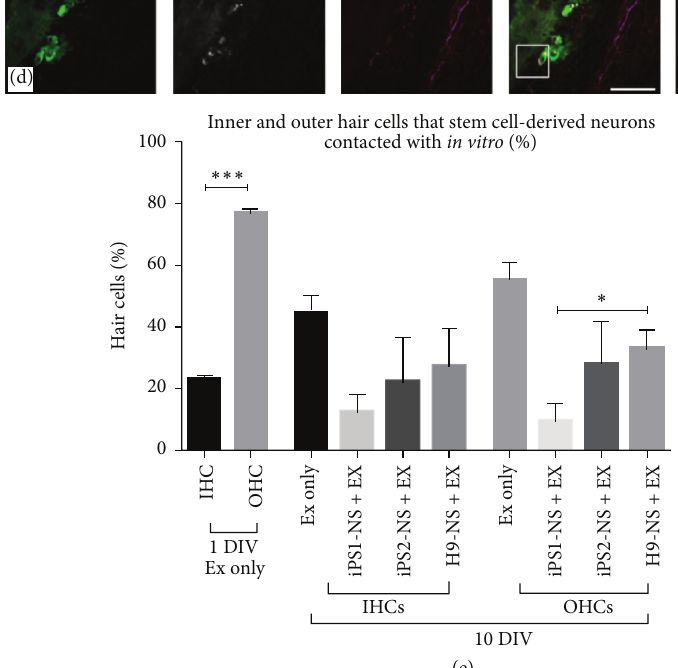
Figure 3: Innervation of inner hair cells versus outer hair cells by stem cell-derived neurons. (a) The specific labeling of Prestin (grey) to the OHCs is depicted in the explant only control. (b–d) The hiPSC- and hESC-derived neural processes made contact with both the IHCs and the OHCs. The merged 1 images represent higher magnification images of the boxed inserts and depict the contacts made between the stem cell-derived neural processes and hair cells. Scale bar = 50 𝜇 m, relevant for all the images. (e) Total numbers of hair cells (inner and outer) were quantified in each group using antibodies against MyoVIIa (all hair cells) and Prestin (outer hair cells only). Data was compared to controls grown for one day in vitro . There was a significantly higher number of OHCs compared to IHCs in the explant only controls after 1 DIV ( 𝑝 < 0.001 ). At 10 DIV, there was a decline in the number of IHCs and OHCs present in the explants. There were no significant differences in the number of OHCs that the stem cell-derived neural processes contacted, when compared to the numbers of IHCs these cells contacted (iPS1 𝑛 = 6 , 𝑝 = 0.79 ; iPS2: 𝑛 = 7 , 𝑝 = 0.73 ; and H9 𝑛 = 6 , 𝑝 = 0.68 ). The iPS1-derived neurons made contact with significantly fewer OHCs compared to the hESC-derived neurons ( 𝑝 < 0.05 ). A Kruskal-Wallis one-way ANOVA was utilized to determine statistical significance between the groups compared. Values of ∗ 𝑝 < 0.05 were considered statistically significant and data presented as the mean ± SEM. OHCs: outer hair cells; IHCs: inner hair cells; DIV: days in vitro . The asterisks ∗ highlight the IHCs present in the